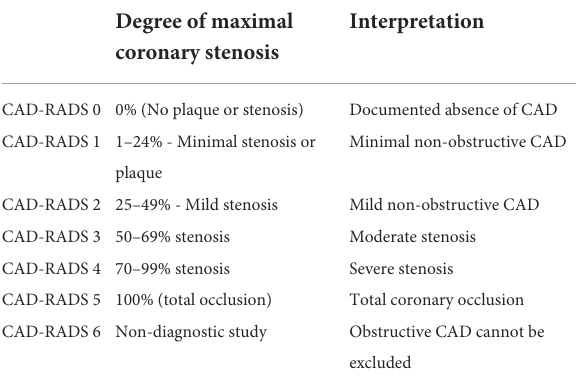
TABLE 1 Diagnostic criteria for coronary stenosis by CCTA and DSA. Degree of